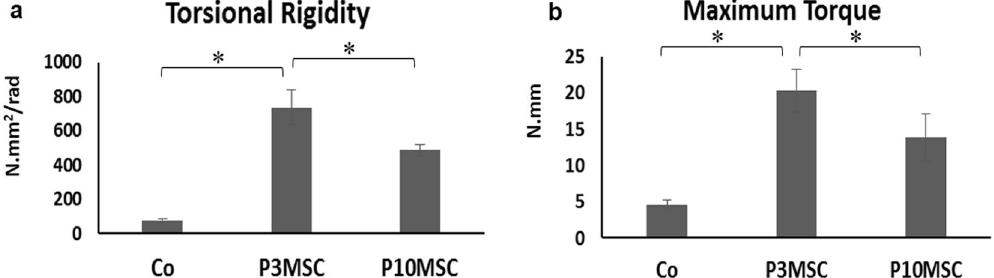
Figure 5. Enhanced biomechanical properties in MSC sheet-wrapped allografts at 6 weeks post-surgery. Mechanical properties of femur samples (n = 6) in groups of allograft alone, P3 MSC sheet/allograft, and P10